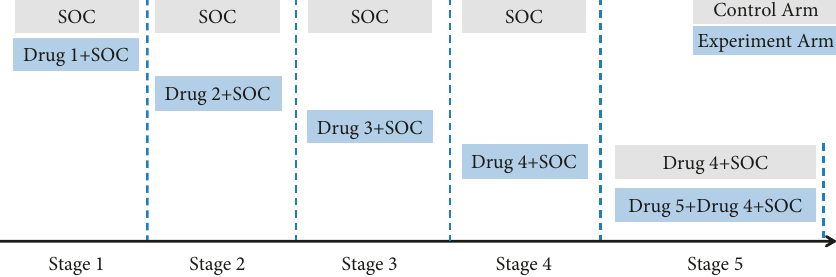
Figure 5: Diagram of COIVD-19 design for testing five drugs. Table 4: Parameters for decision between five